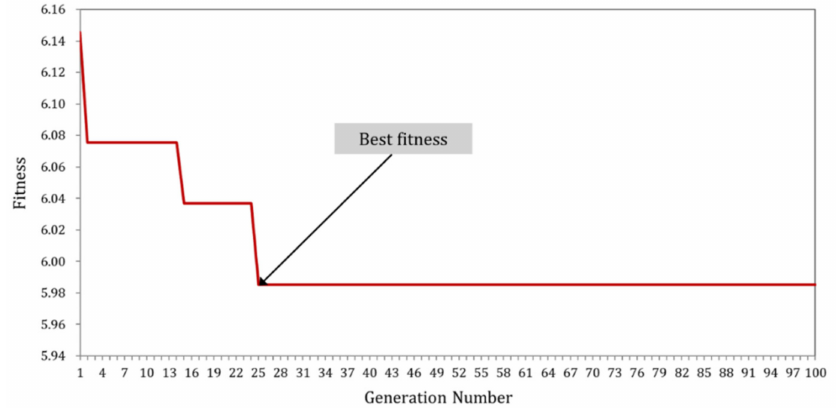
Figure 4. Evolution of the fitness function in terms of the generations during the optimization